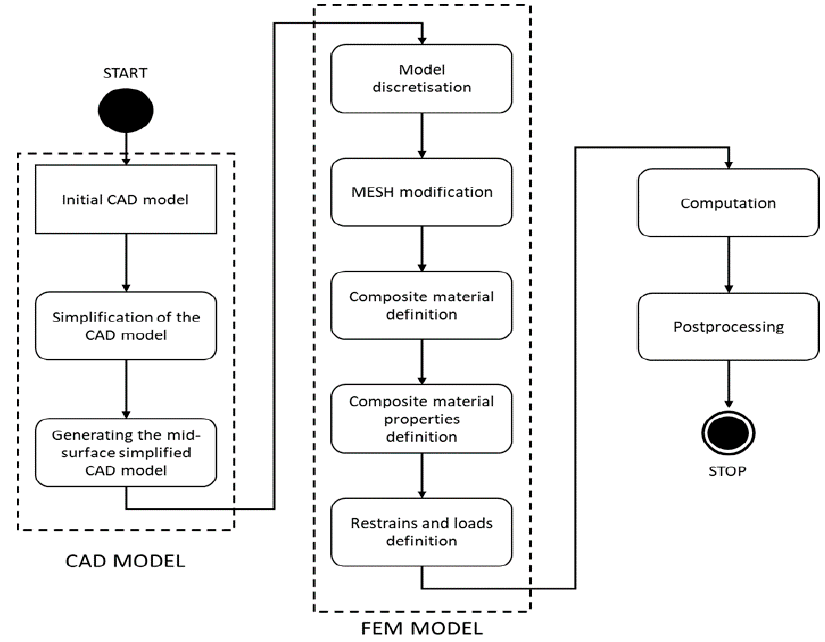
Figure 8. The methodology of the Finite Element Method (FEM) validation.